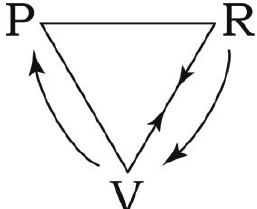
Figure 2: The Transactional Switch Drama